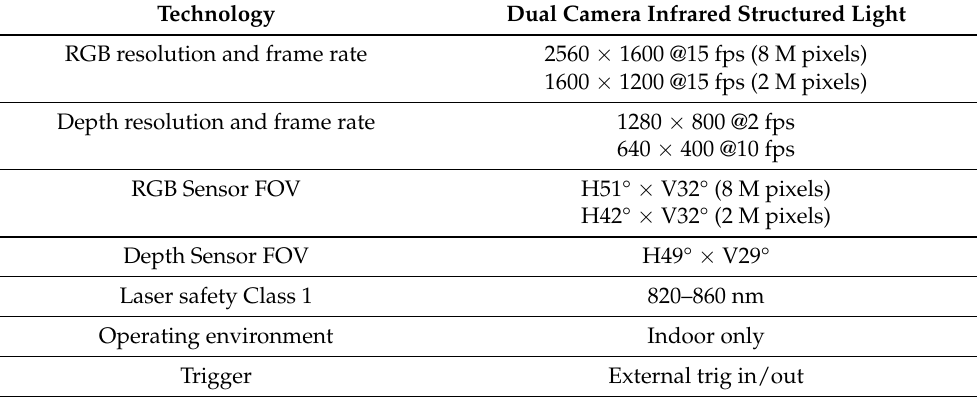
Table 2. Acusense RGB-D technical specifications.